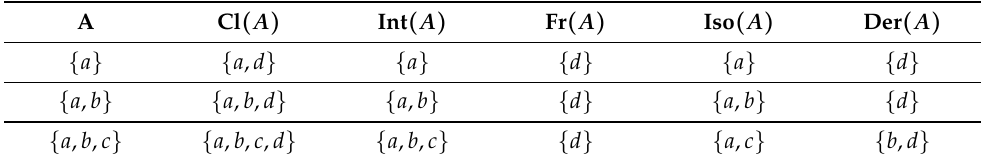
Table 2. Classification Results in an